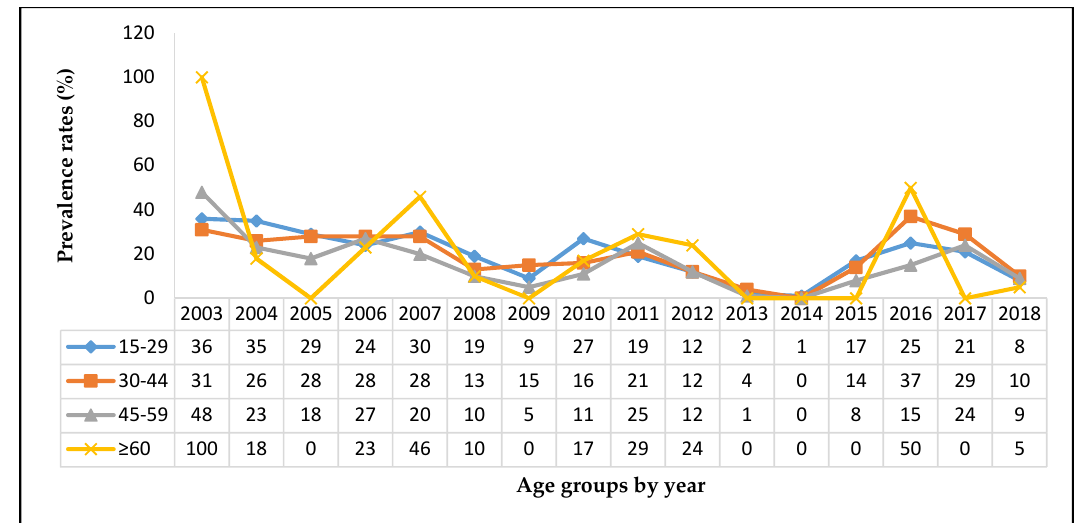
Figure 4. Annual prevalence rates of HBV in blood donors from 2003–2018 by age group.